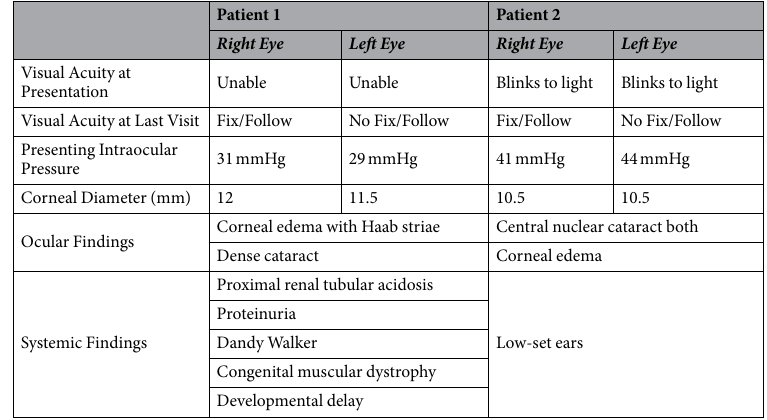
Table 1. Clinical presentation of Lowe syndrome patients.